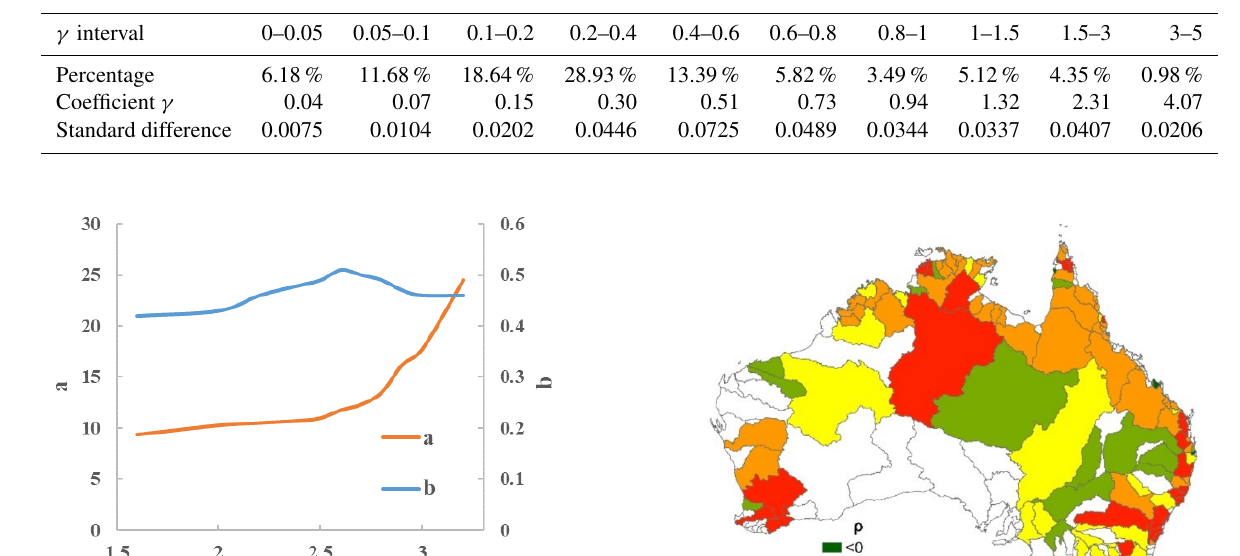
Figure 5. The relationships between maximum river width and cumulative upstream runoff (a) , upstream drainage area (b) , and river gradient (c) (the colour coding is related to data counts with the highest in dark blue and lowest in light blue, which corresponds to the histogram on the axes; red dash line: the threshold (data below this threshold are excluded due to the influence of their sparse distribution on the overall relationship when we fitted Eq. 1 to our data)). Table 4. Validation of curves fitting for different river morphology categories.